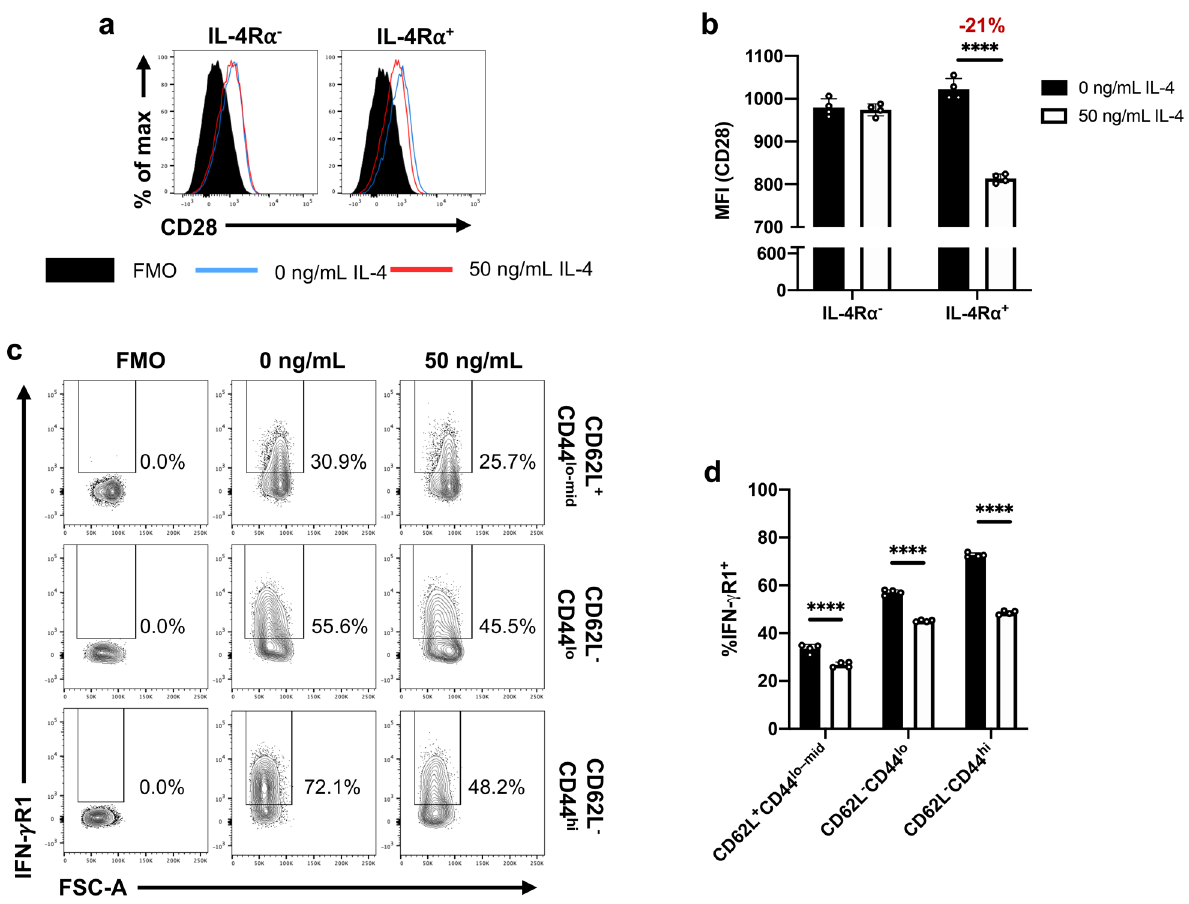
Figure 7. IL-4 stimulation downregulates CD28 and IFN-γR1 expression on CD4 T cells. Whole spleen homogenate derived from naïve 6–8-week-old female BALB/c mice ( n = 4) were stimulated with 50 ng/mL IL-4 for 24 h. (a) Representative histograms showing CD28 expression on pre-gated CD4 T cells partitioned based on their IL-4R ⍺ status. (b) MFI (CD28) for each treatment condition. (c) Representative contour plots showing the expression of IFN-γR1 on pre-gated CD4 T cells for each CD62L:CD44 status. (d) The proportion of cells deemed IFN-γR1 + . Data are represented as mean + SD, where dots represent biological replicates from a